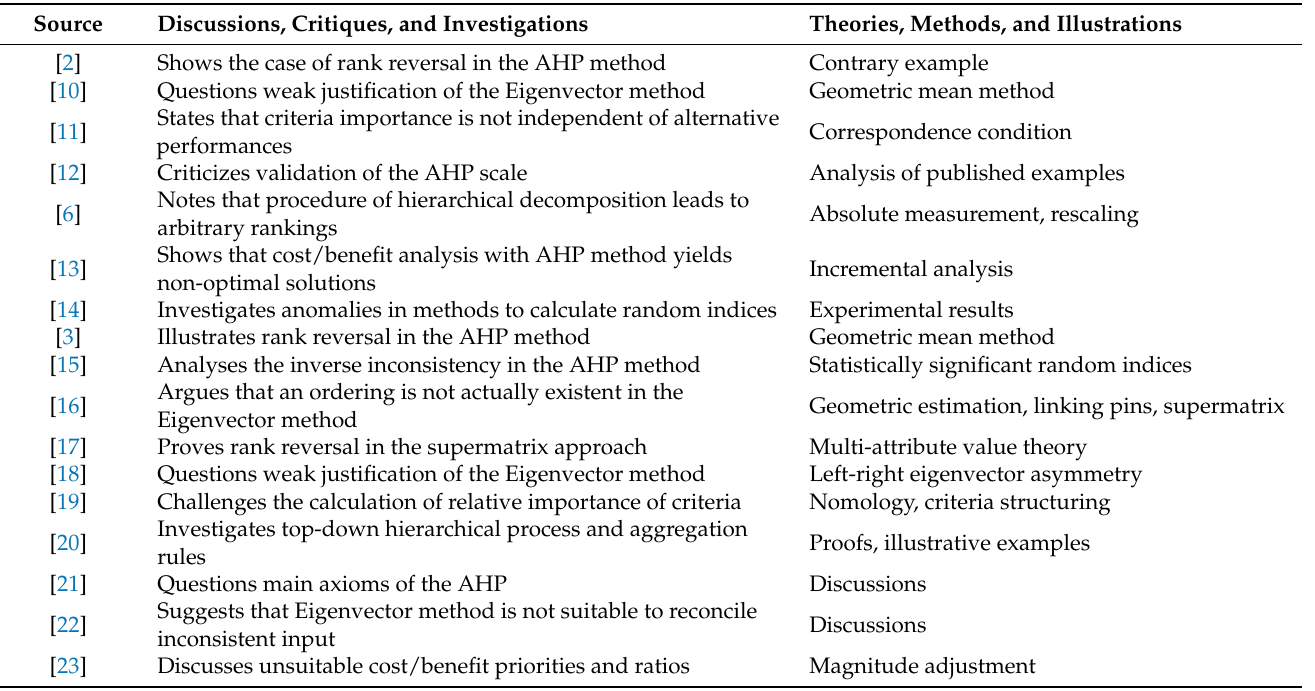
Table 1. Summary of enquiries into decision-making anomalies and